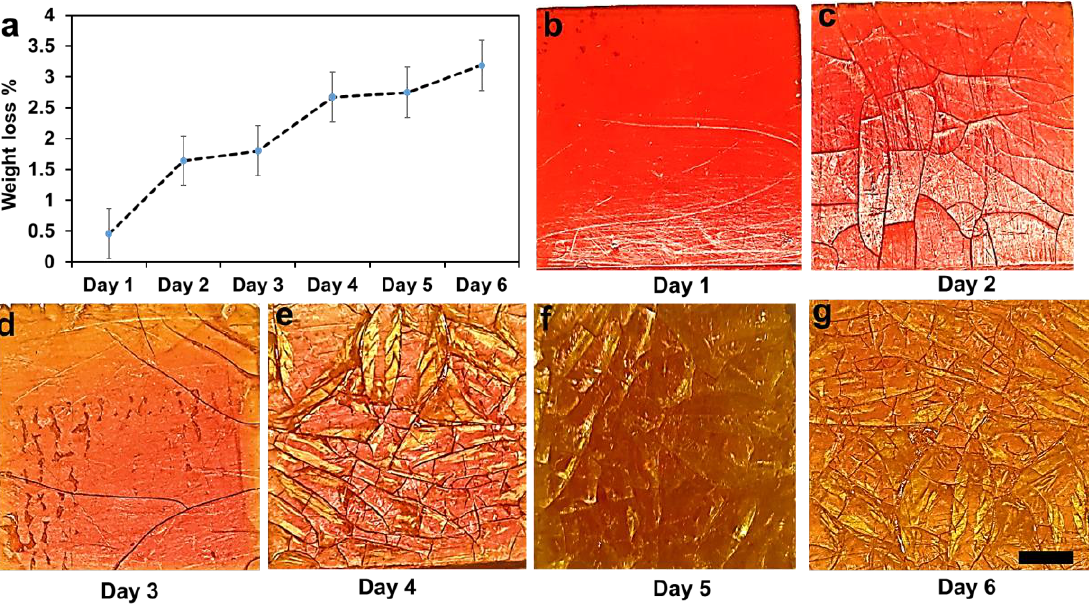
Figure 4. Weight loss of the composites up to six days. ( a ) Weight loss percentage over 6 days. ( b )– ( g ) Degradation processes were carried out at room temperature (25 °C) in PBS. Scale bar 0.5 mm.